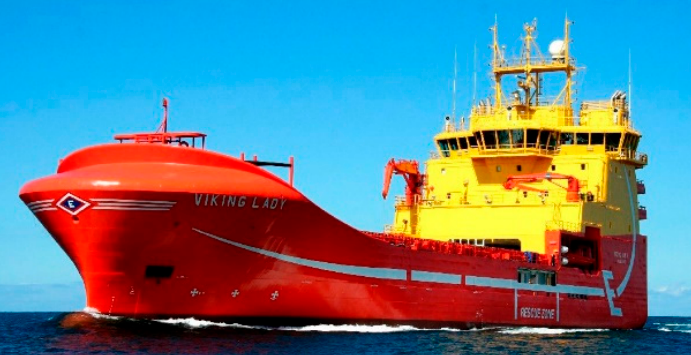
Figure 13. The supply ship “Viking Lady” [76].